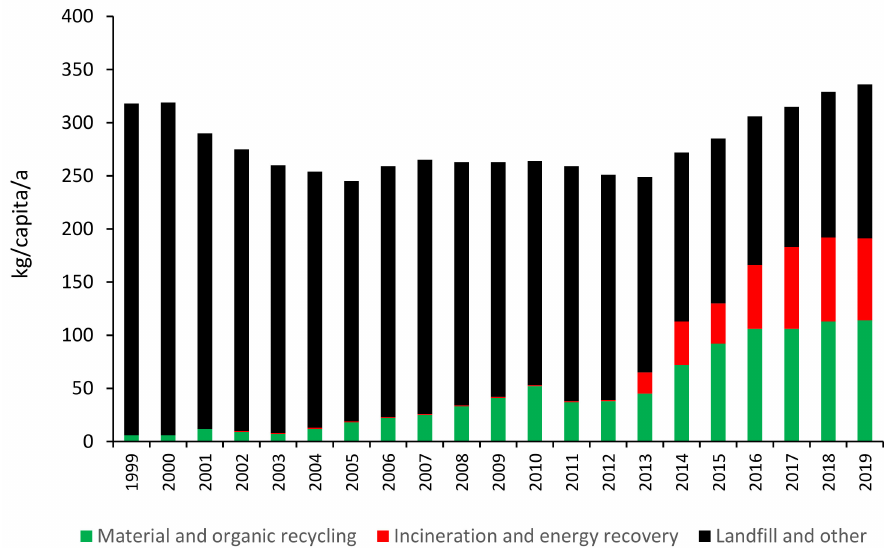
Figure 2. Municipal waste management in Poland; source: Eurostat database